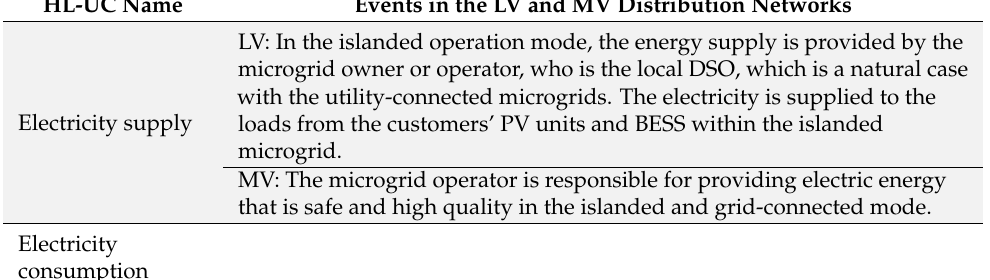
Table 4. Energy management high-level use cases in the microgrid